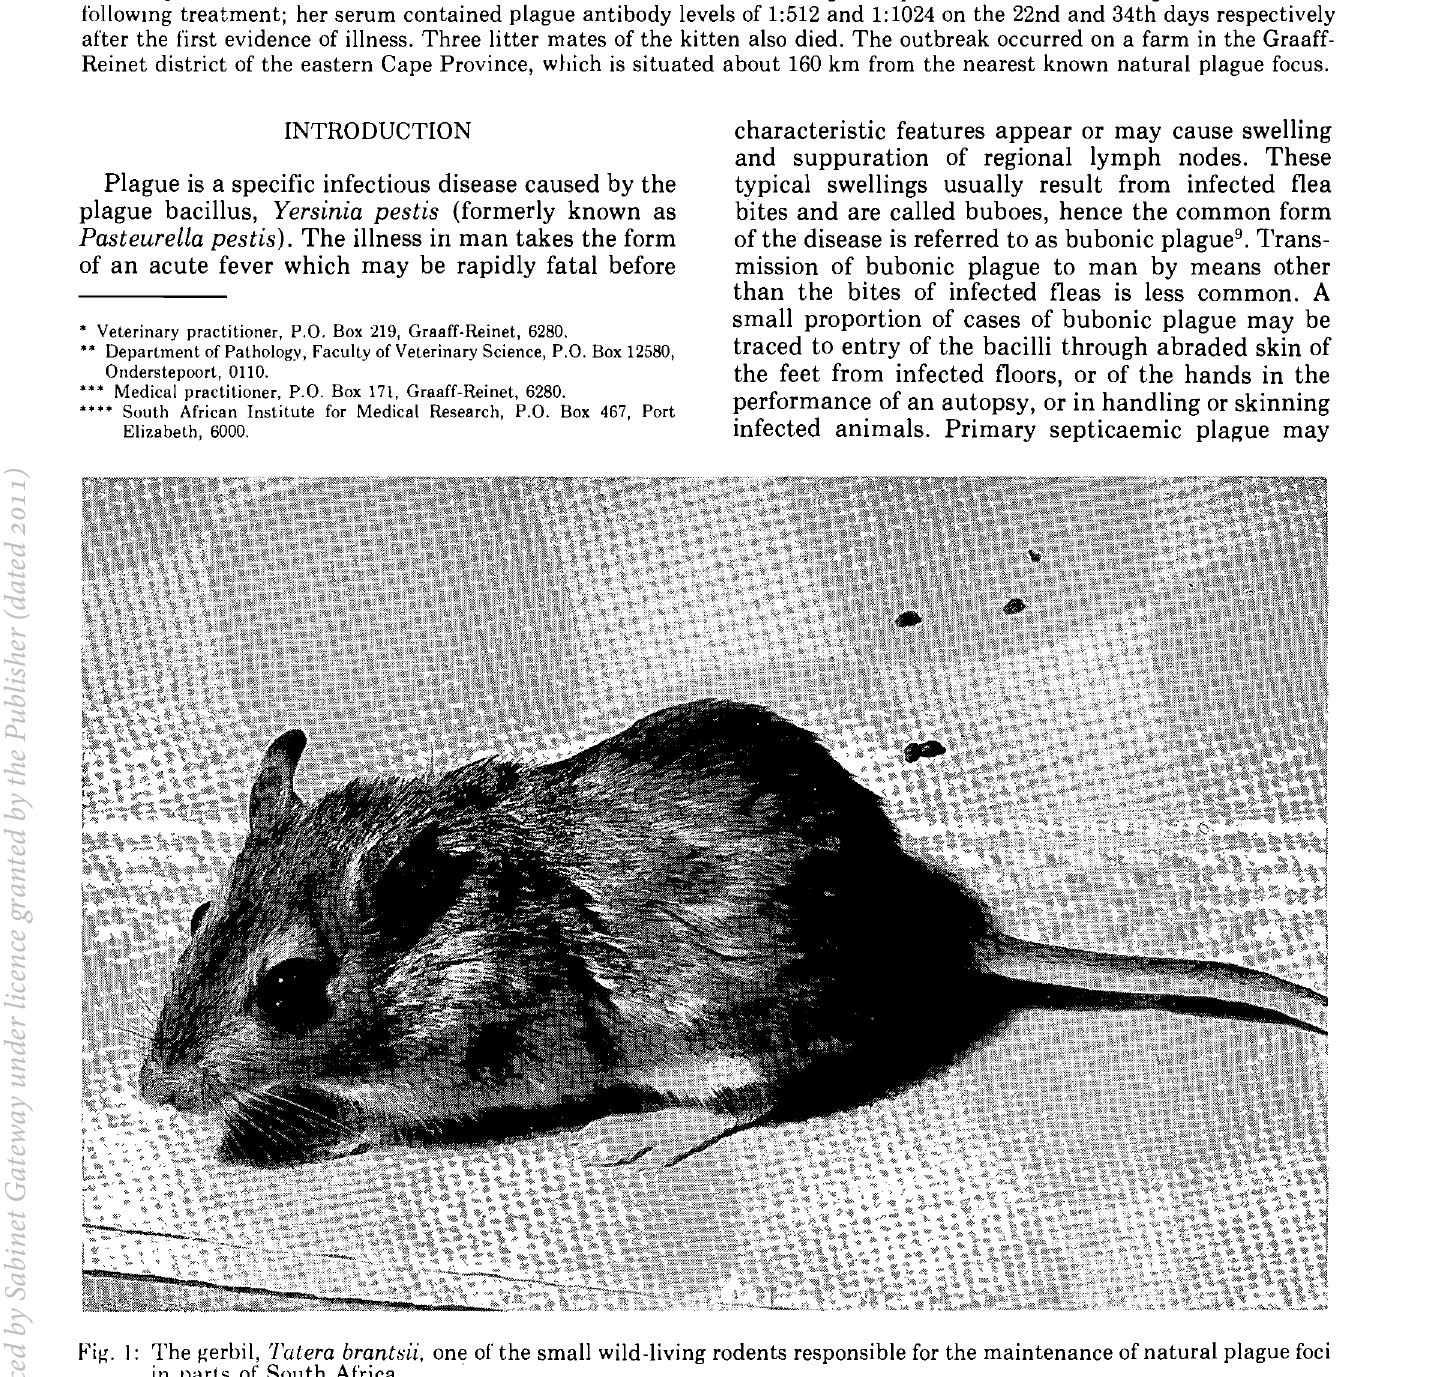
Fil{. I: The I{erbil, Tatera brantsii, one of the small wild-living rodents responsible for the maintenance of natural plague foci in parts of South Africa.